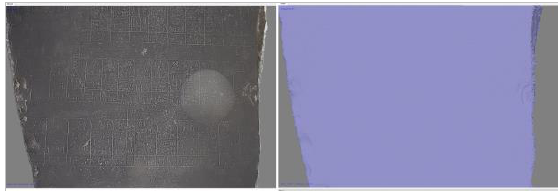
Figure 6: Details of the S8+ 3D model; both texture and